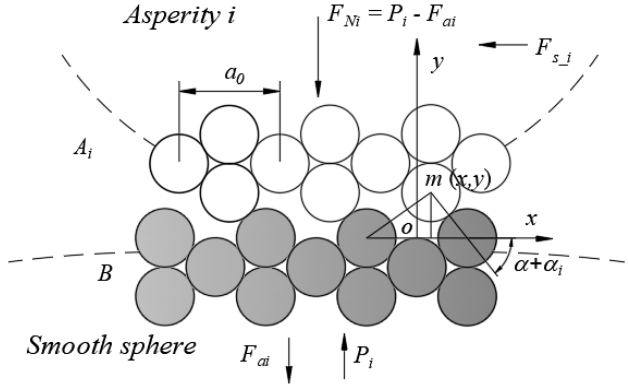
Figure 2. Schematic of contact between asperity i and smooth